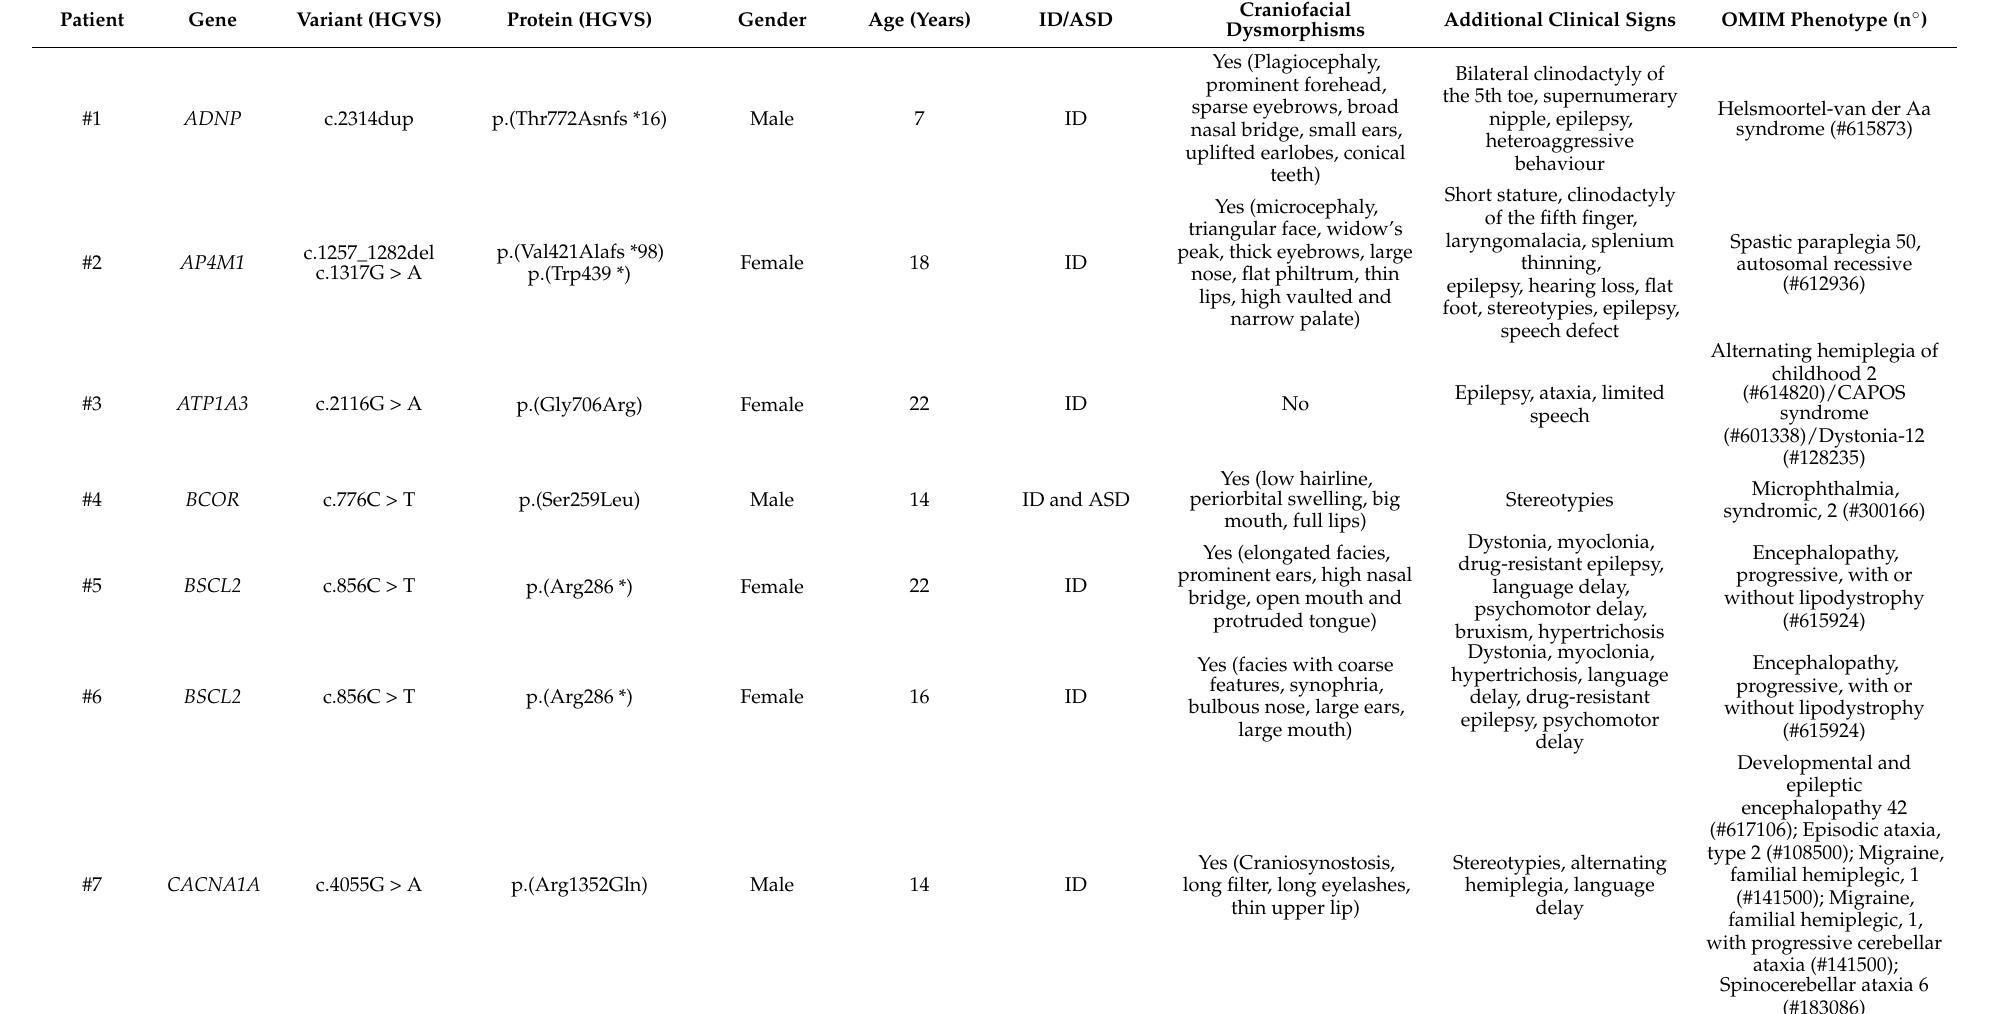
Table 1. Clinical features of patients with pathogenic variants in disease